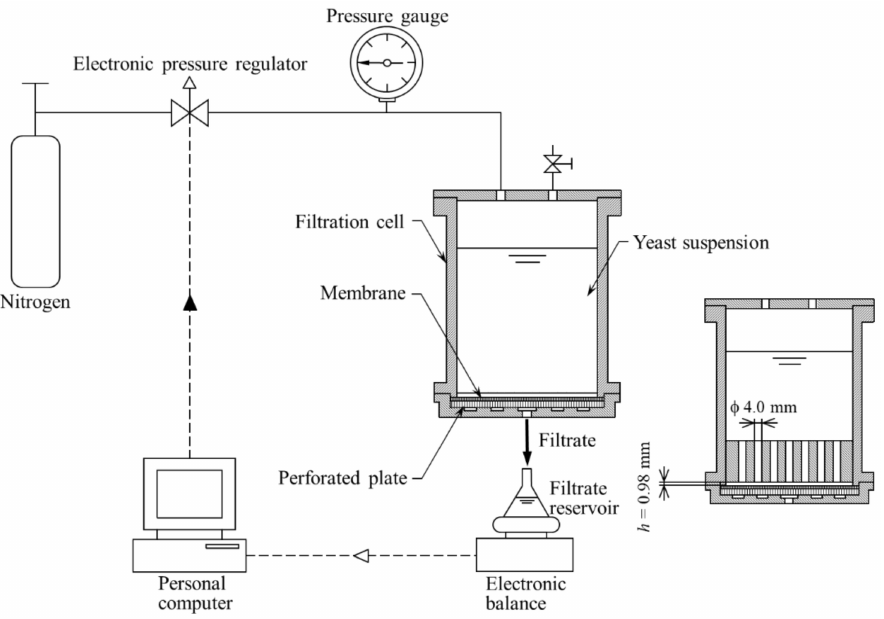
Figure 1. Schematic of the apparatus for microfiltration